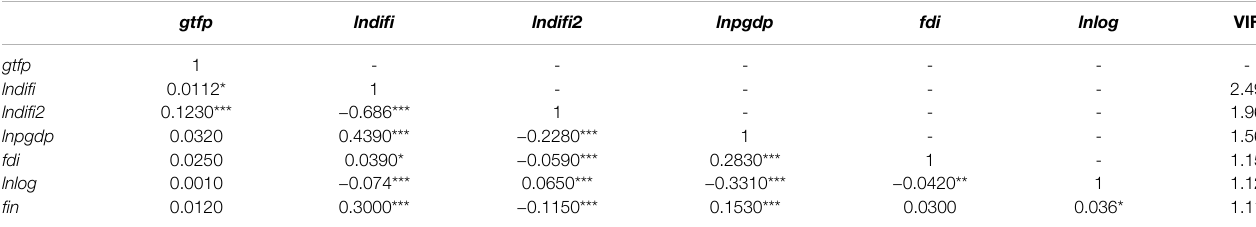
TABLE 2 | The correlation coef fi cient and multicollinearity test of varibles.